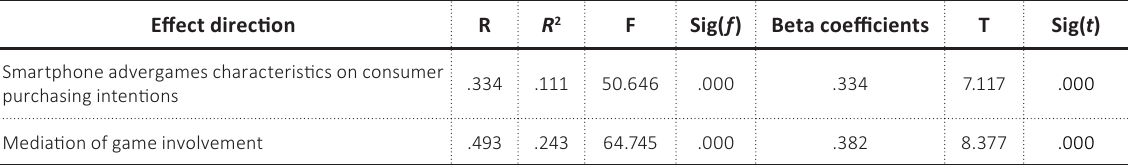
Table 15. Hierarchical linear regression for testing the second main hypothesis Effect